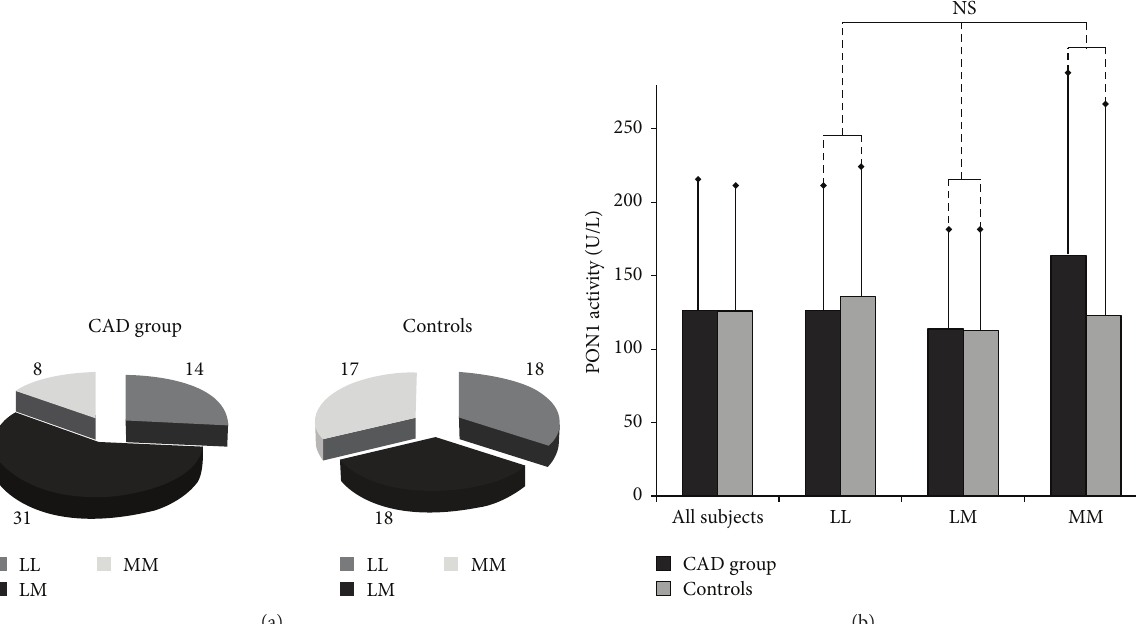
Figure 2: The Q192R polymorphism of the PON1 gene: (a) the percentage distribution of PON1 genotypes in the patient and control groups; (b) the association of Q192R polymorphism with serum PON1 activity.